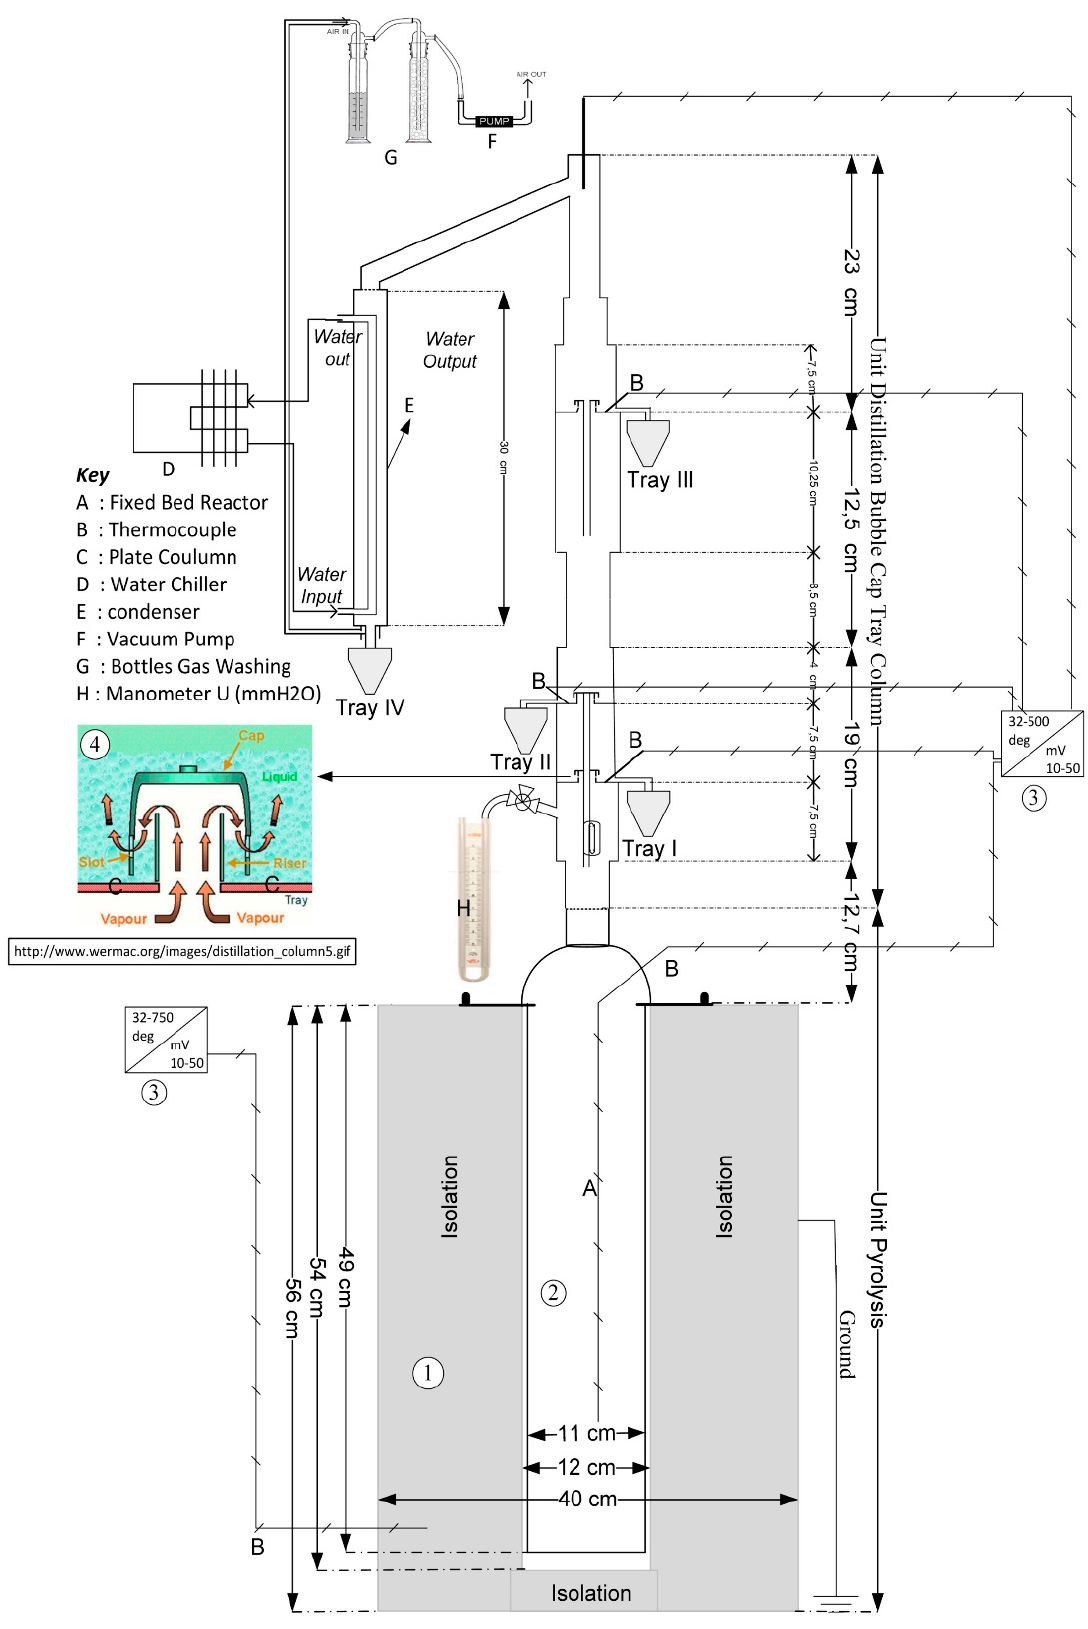
Figure 2. Schematic diagram of thermal pyrolysis integrated with a distillation bubble cap column, reproduced with permission [107] . Table 7. Distribution of fuel products along the column [107] .